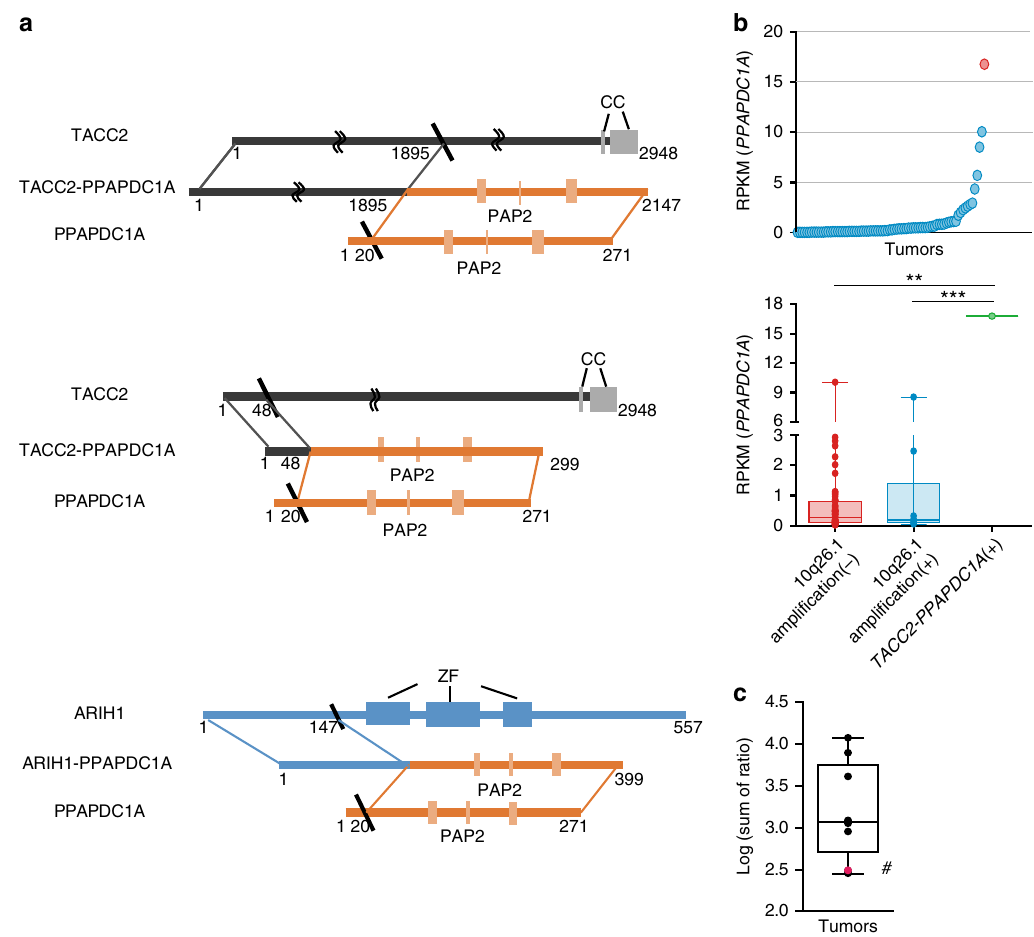
Fig. 6 The PPAPDC1A in-frame fusions identi fi ed by targeted RNA sequencing ( a ) Schematic representation of the PPAPDC1A fusions. Top and middle panels, TACC2-PPAPDC1A fusions; Bottom panel, ARIH1-PPAPDC1A . CC, Coiled-coil domain; PAP2, PAP2 domain; ZF, Zinc fi nger domain. ( b ) Left, PPAPDC1A RPKM values for the 80 discovery set DGCs. Each circle represents each tumor. Sample ordering according to the PPAPDC1A RPKM. Magenta circle, early-onset DGC expressing TACC2- PPAPDC1A . Right, PPAPDC1A RPKM values for the discovery set DGCs with and without 10q26.1 gene ampli fi cation. Turquoise circle, early-onset DGC expressing TACC2- PPAPDC1A . Box plots display 5%, 25%, median, 75%, and 95%. ( c ) Lipidomic pro fi ling data for DGCs with or without TACC2-PPAPDC1A . The sum of the mass spectral peak area ratio between phosphatidic acid (PA, the substrate of PPAPDC1A) and diacylglycerol (DG, the product of PPAPDC1A) was signi fi cantly lower in an early-onset DGC expressing TACC2-PPAPDC1A in